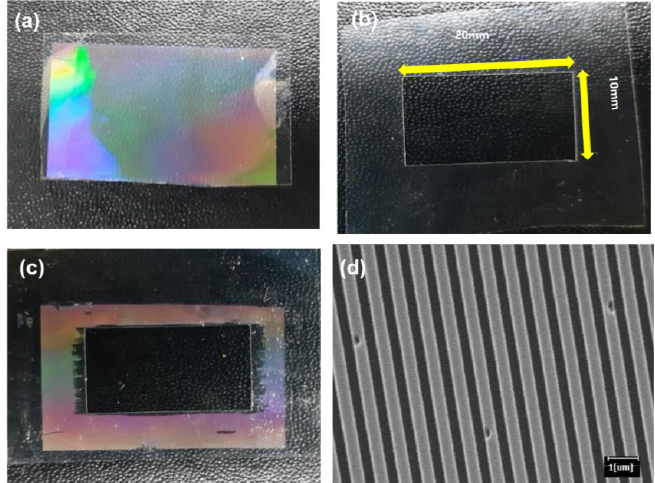
Figure 2. ( a ) A picture of a polyurethane acrylate (PUA) mold, replicated from a master. ( b ) Transparent shadow mask, prepared by a conventional cutting machine. ( c ) Shadow mask, after curing the prepolymer outside of the boundary. ( d ) Scanning electron microscopic (SEM) image of the nanoscale